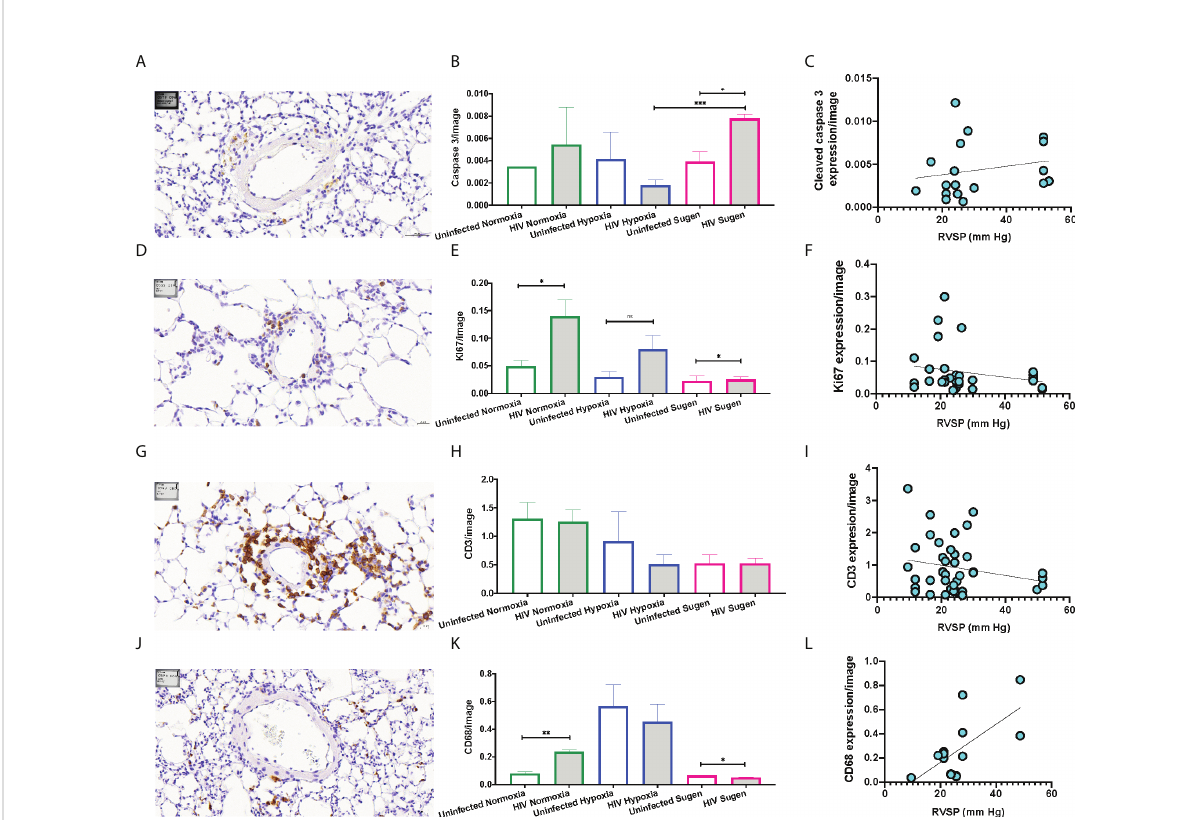
FIGURE 5 Representative immunohistochemical staining of human cell markers in humanized mouse pulmonary vasculature. Formalin- fi xed paraf fi n- embedded mouse lung tissues were processed and stained on a Leica Bond automated immunostainer using a -Cleaved Caspase-3 (A) , a -Ki67 antibody (D) , human a -CD3 (G) , human a -CD68 (J) , primary antibodies with relevant HRP secondary antibodies and isotype controls. Tissues were counterstained with hematoxylin nuclear stain (blue). DAB substrate was applied for detection and the brown signals were quanti fi ed and plot in bar graphs for each marker (Panels B, E, H, and K ). The Pearson R squared between the mean Pulmonary Artery Pressures (mPAP) and immunohistochemical staining was calculated using GraphPad Prism (Panels C, F, I, and L ) using data collected from n=33 mice (9 males and 25 females). Statistical signi fi cance is indicated as follows: ns, non-signi fi cant; *,p<0.05; **p<0.01; ***p<0.001. Data are depicted as mean,